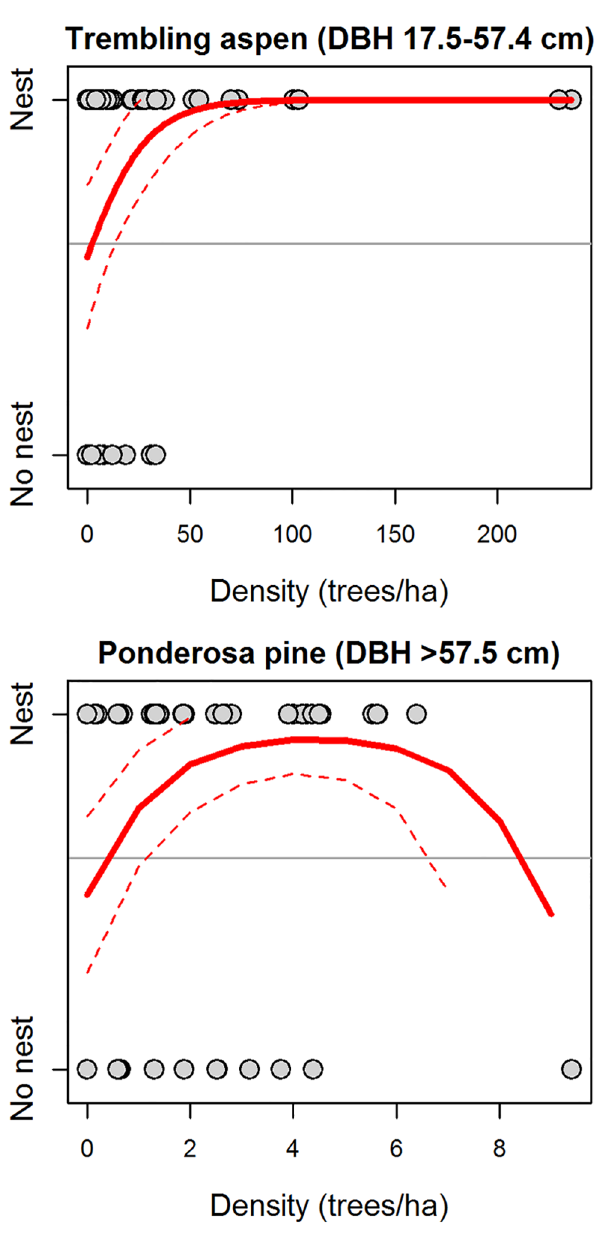
Fig 5. Predicted relationships between probability of nest occurrence and two forest habitat variables included in the Field225 model (18 variables originally considered) for the Western Region of the Williamson ’ s sapsucker Area of Occupancy in British Columbia, 2006 – 2008. Grey points depict nest occurrence ( ‘ Nest ’ ) or a random point ( ‘ No nest ’ ), and the title of each plot indicates the habitat variable. Solid lines indicate predicted values and thin dashed lines represent the 95% prediction interval. Horizontal line depicts proportion of points that were nests (i.e., the baseline probability of response variable having a value of